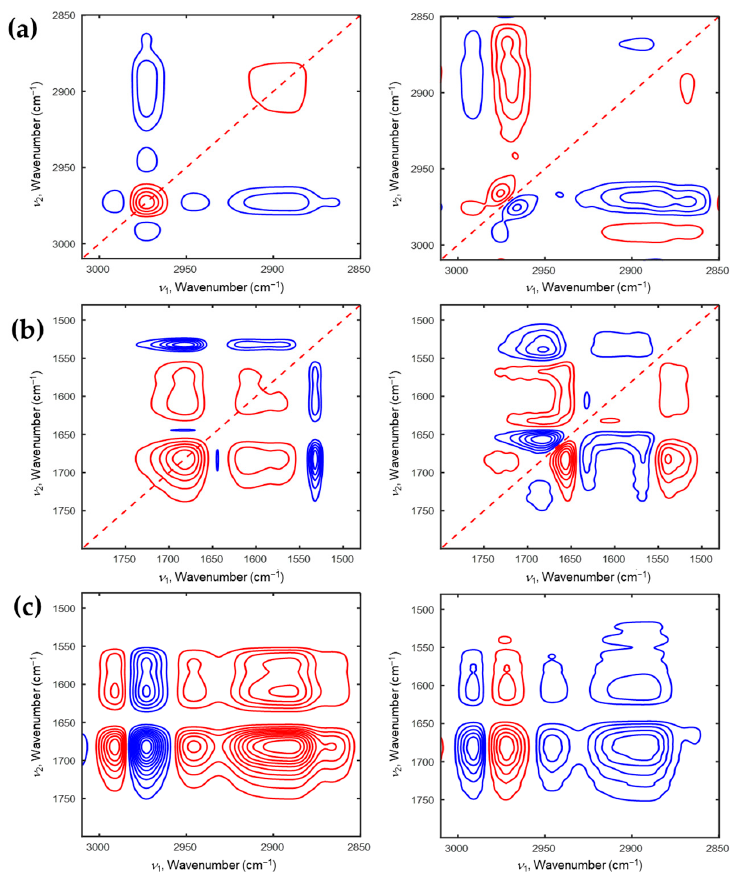
Figure 3. 2D correlation spectra of P(NiPAAm- co -AAc) hydrogel of pH4 during the heating process ( a : 3010–2850 cm − 1 , b : 1800–1480 cm − 1 ). Hetero-mode 2D correlation spectra ( c ) of P(NiPAAm- co -AAc) hydrogel during the heating process for the 3010–2850 cm − 1 and 1800–1490 cm − 1 regions.